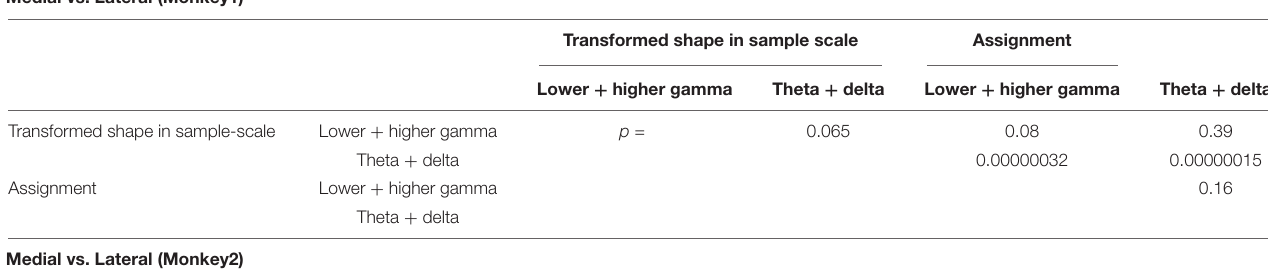
TABLE 2 | Wilcoxon rank-sum test between the STFM distributions shown in Figures 5F,G . Medial vs. Lateral